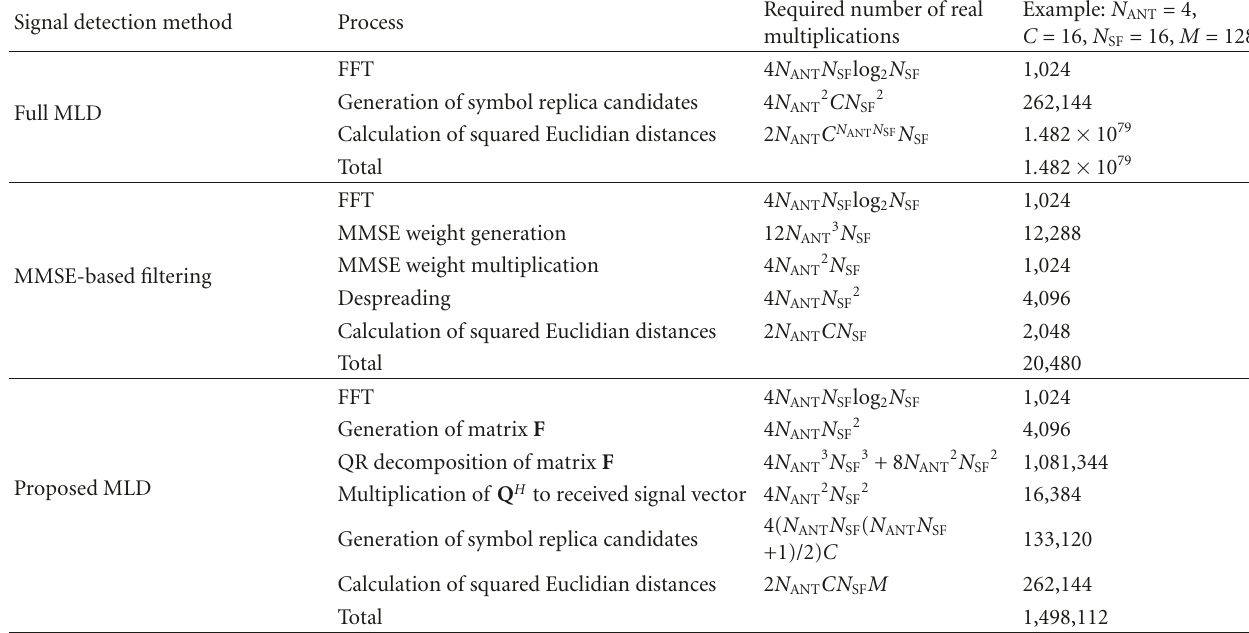
Table 2: Number of real multiplications per symbol required for signal